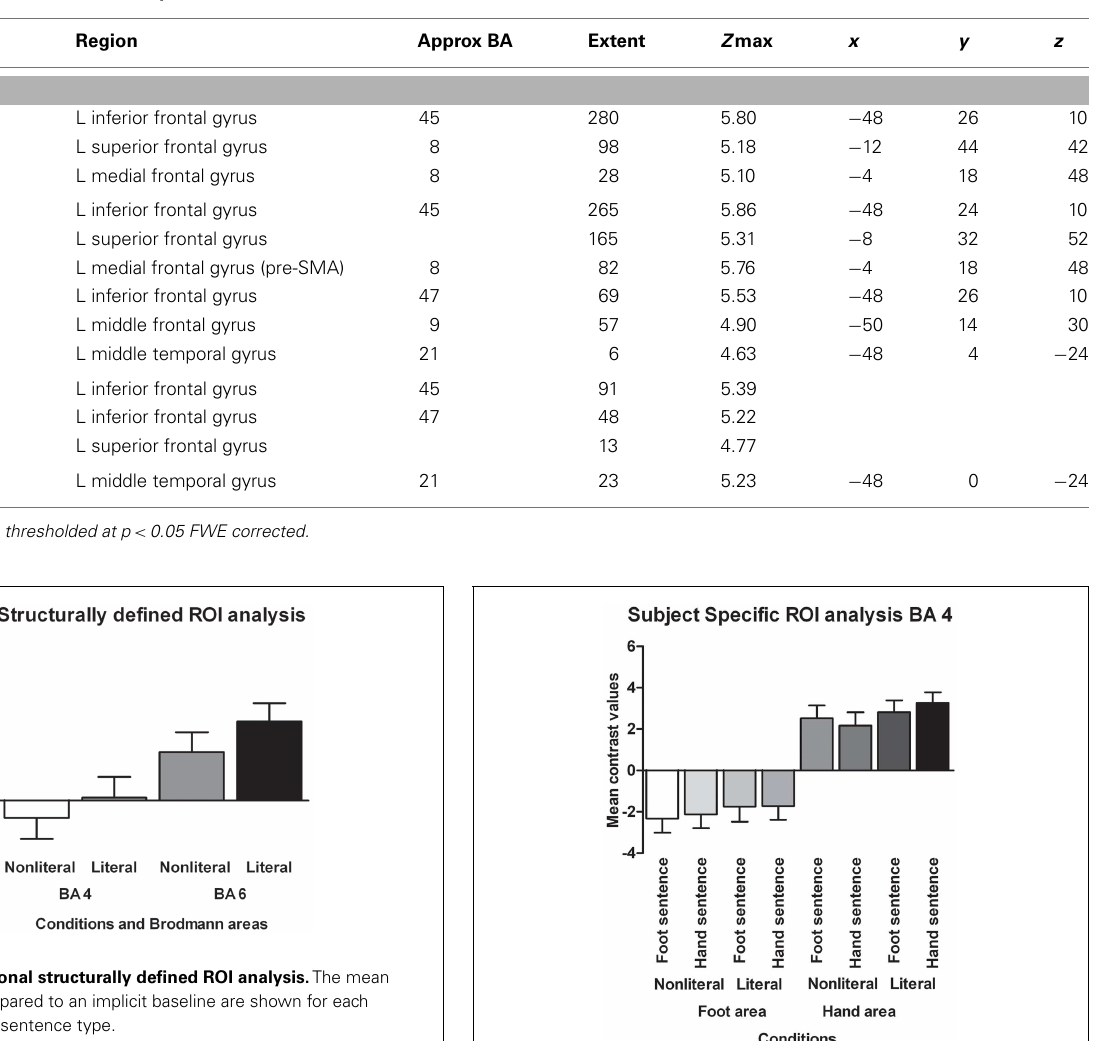
TableA1 |Additional whole brain analysis.